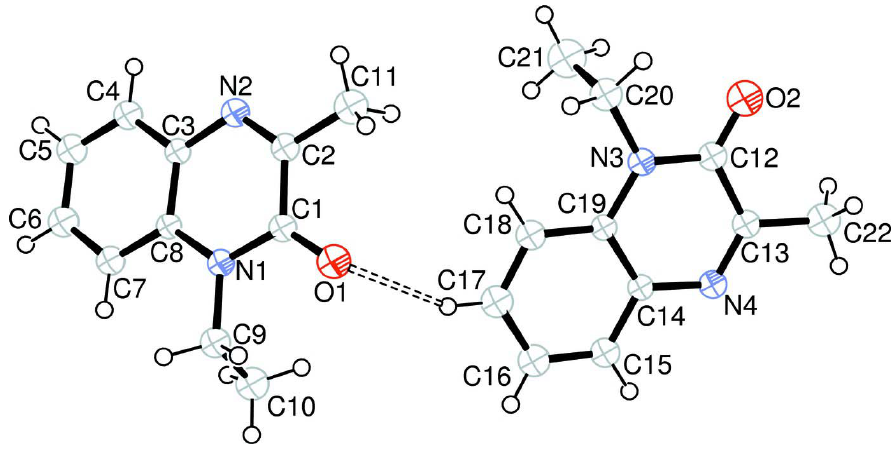
Figure 1 The molecular structure of the title molecule, with the atom-numbering scheme. Hydrogen bond is shown as dashed line.